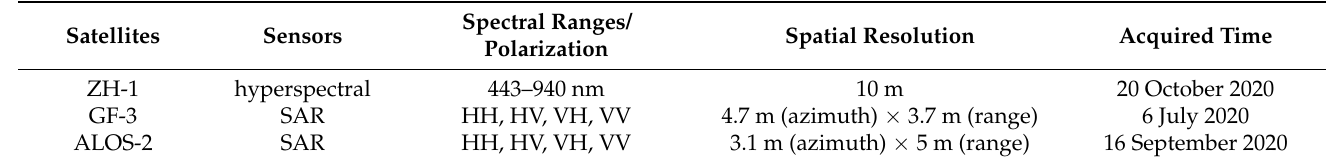
Table 1. Summary of main parameters of active and passive remote sensing images. Satellites Sensors